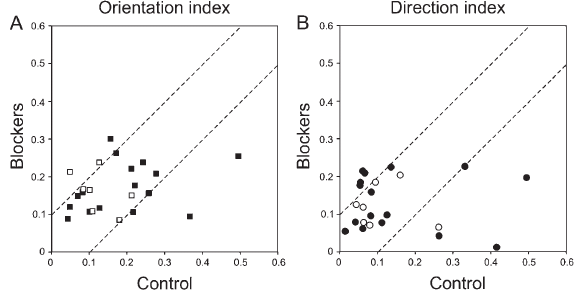
Figure 6. Direction and orientation indices of 24 V2 neurons. A , Correlation between the orientation indices before and after GABA (filled symbols) or lidocaine (open symbols) injections into area V2. B , Correlation between the directional indices before and after GABA or lidocaine injections. Broken lines with a slope of 1 represent the limits of significance for the changes in the indices ( . 0.2). Significant changes in direction index (9/24) and in orientation index (5/24) were observed for these cells (P ,